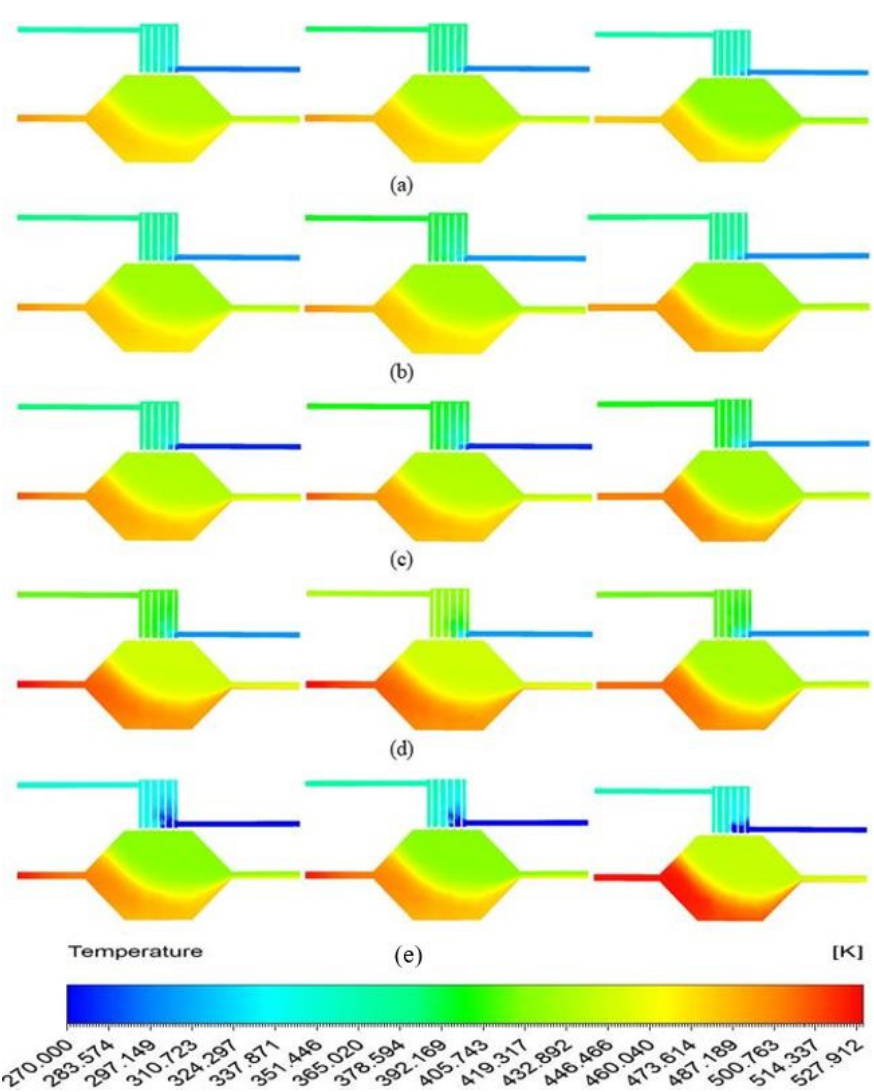
Figure 8. The average temperature in a steady state for HPHE with inlet air velocities of 0.3 m/s, 0.5 m/s and 0.7 m/s from left to right, with different air inlet temperatures of ( a ) 150 °C ( b ) 175 °C ( c ) 200 °C ( d ) 225 °C and ( e ) 250 °C.